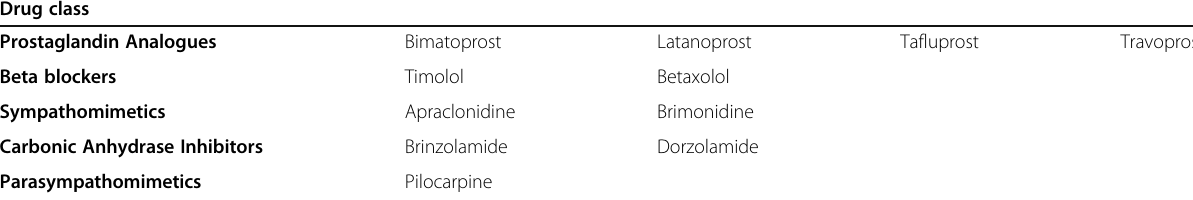
Table 2 PBS list of glaucoma medications Drug